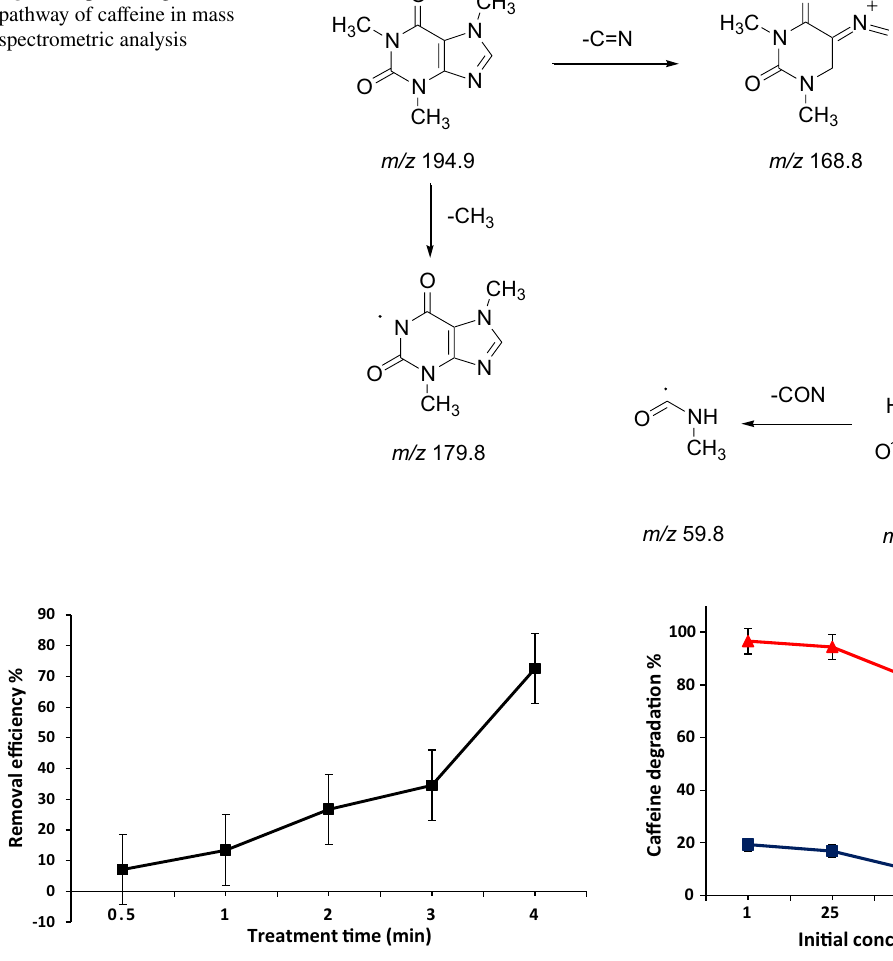
Fig. 4 Caffeine removal efficiency (%) from aqueous solution at 0.5, 1, 2, 3 and 4 min plasma treatment times. Initial caffeine concentra- tion: 100 µg/mL; initial pH: 7 and input plasma power: 60 W